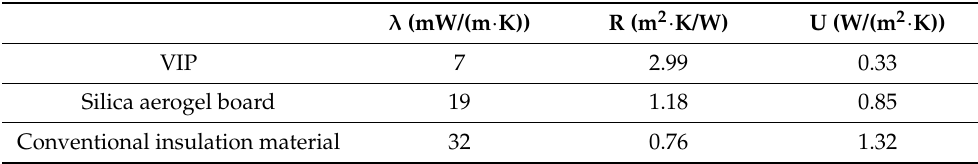
Table 5. Thermal resistance and U-value of a simplified train wall with different insulation for a given thickness of 20